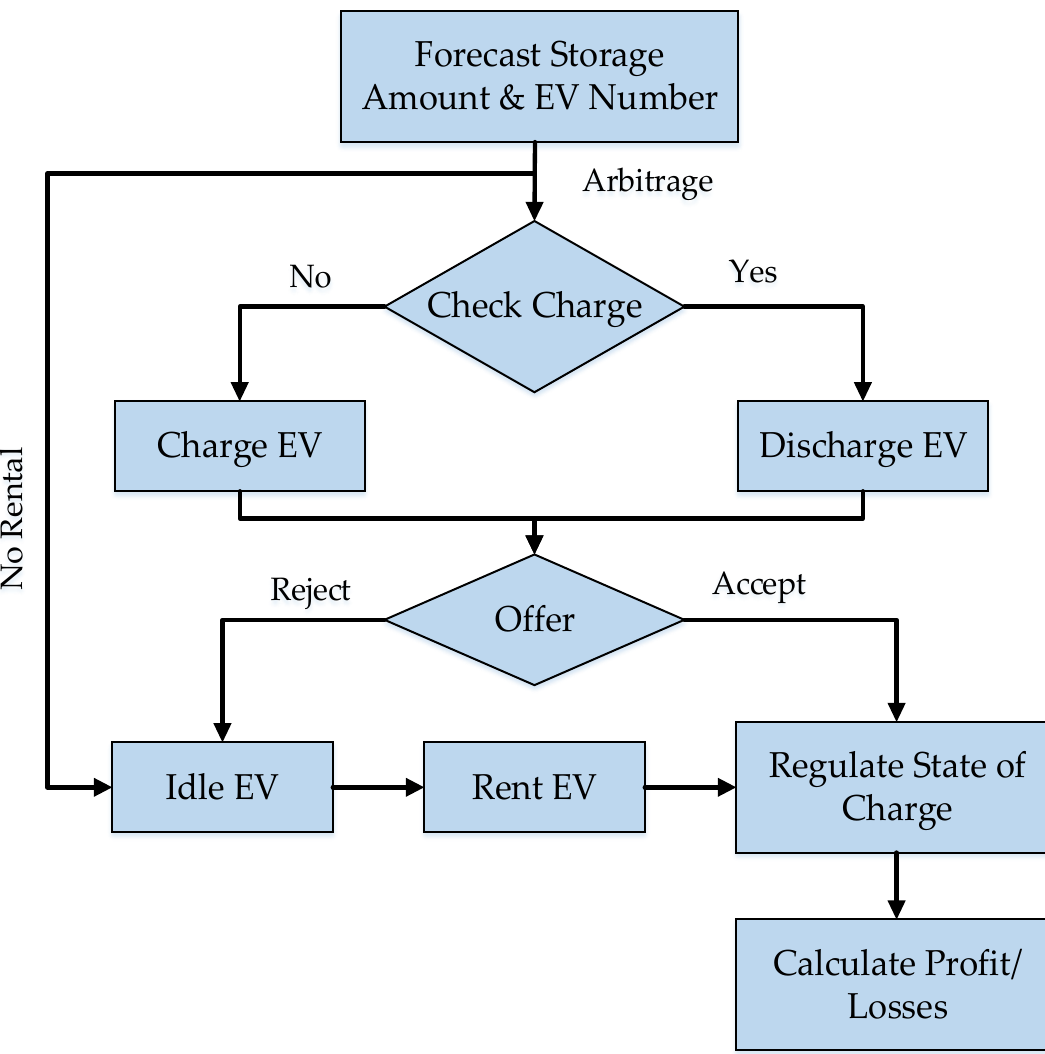
Figure 10. A mixed rental-trading strategy for the virtual power plant coupled with electric vehicle (EV). (Redrawn with permission from [81], 2018, Wiley Periodicals, Inc. on behalf of Production and Operations Management Society).